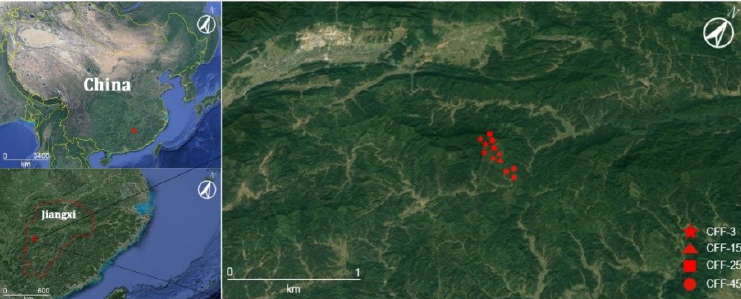
Figure 1. Location of Chinese fir plantations with varying ages in Jiangxi Province of China. CFF-3, 3-year Chinese fir forests; CFF-15, 15-year Chinese fir forests; CFF-25, 25-year Chinese fir forests; CFF-45, 45-year Chinese fir forests.